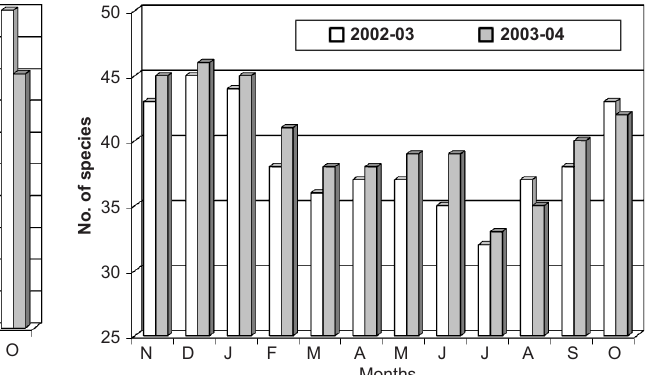
Figure 2. Monthly variations in species richness of phytoplankton of Waithou Pat